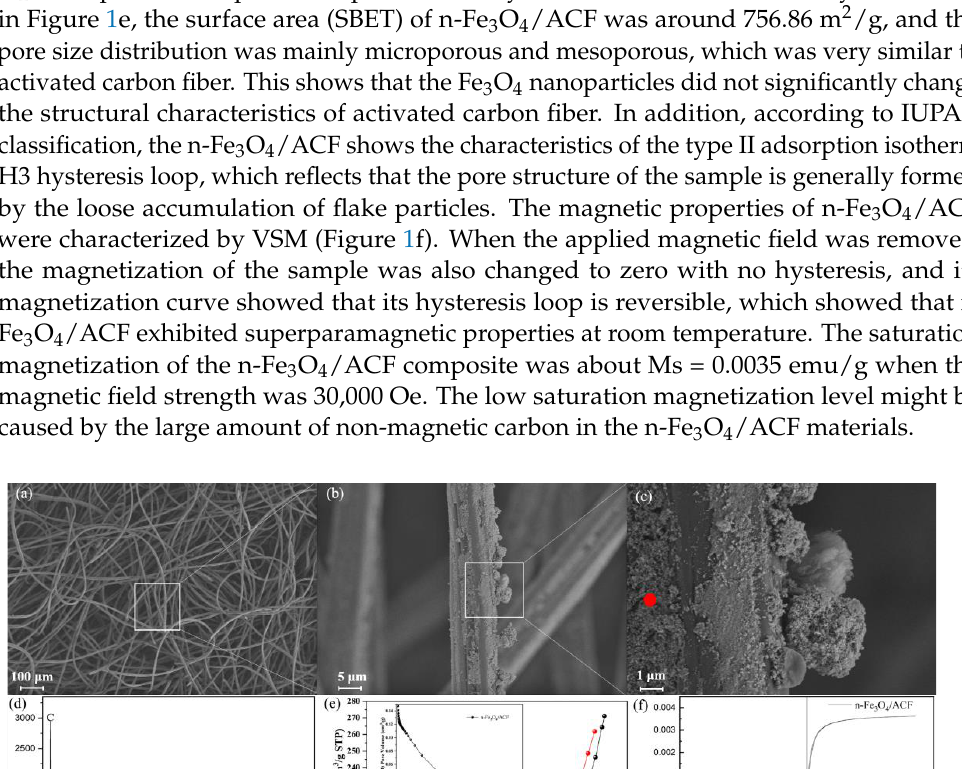
(Figure 1d). In order to evaluate the specific surface area and pore structure of n-Fe 3 O 4 /ACF,